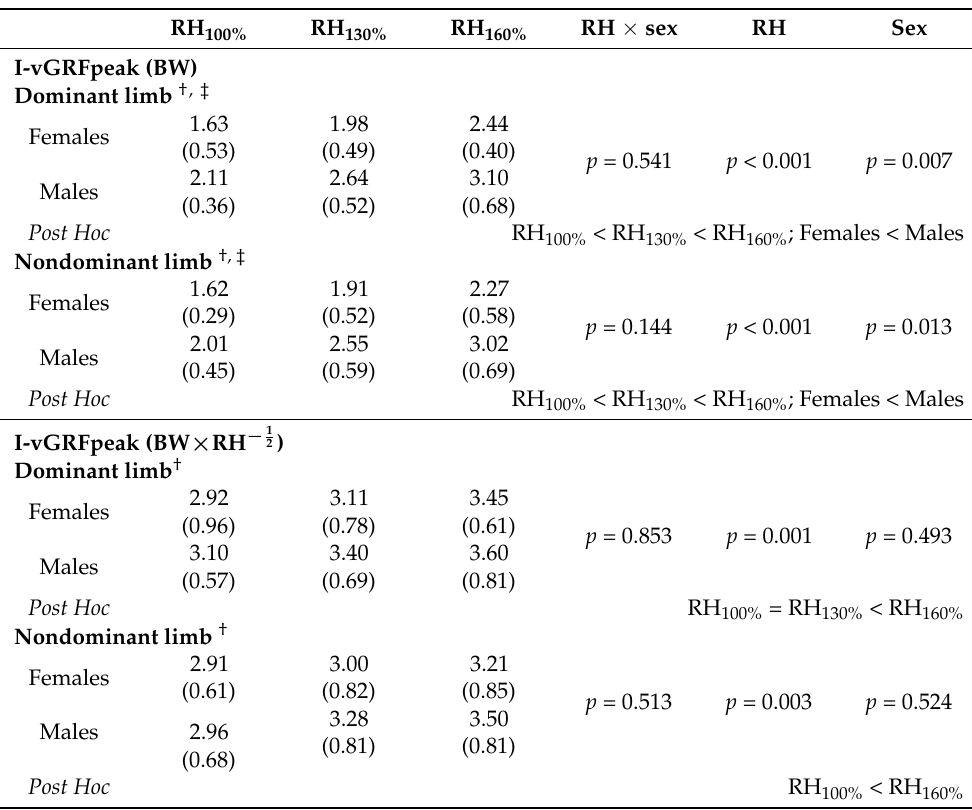
Table 2. I-vGRFpeak for both limbs.